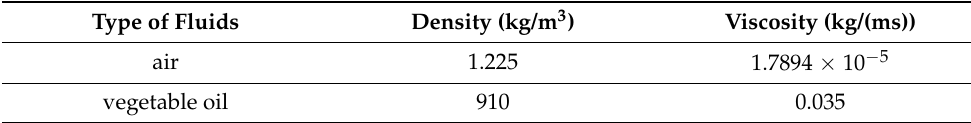
Table 3. Materials involved.